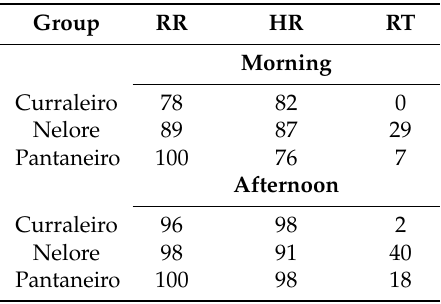
Table 4. Percentage of animals within each genetic group above reference values for respiratory rate (RR) heart rate (HR) and rectal temperature